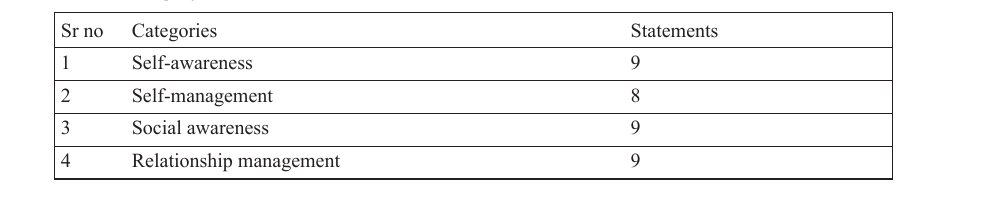
Table 3 Category wise distribution of statements